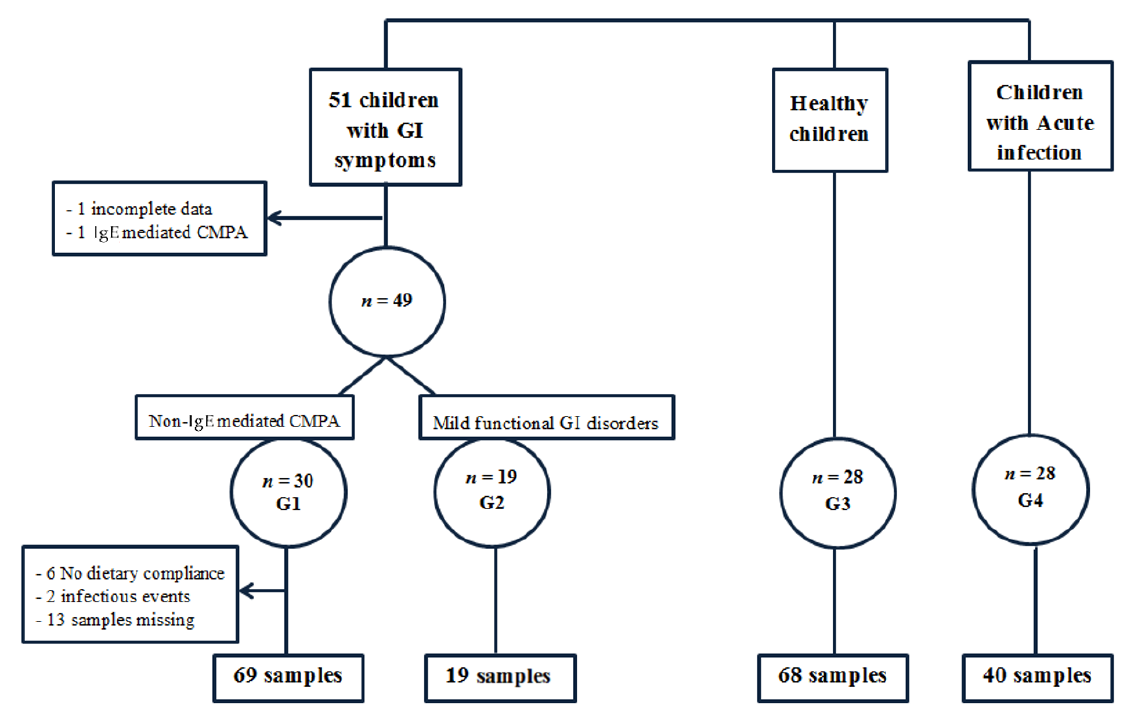
Figure 1. Flow chart of infants included in the study. GI = gastrointestinal; Ig = immunoglobulin, CMPA = cow’s milk protein allergy, G1, G2, G3, G4 =